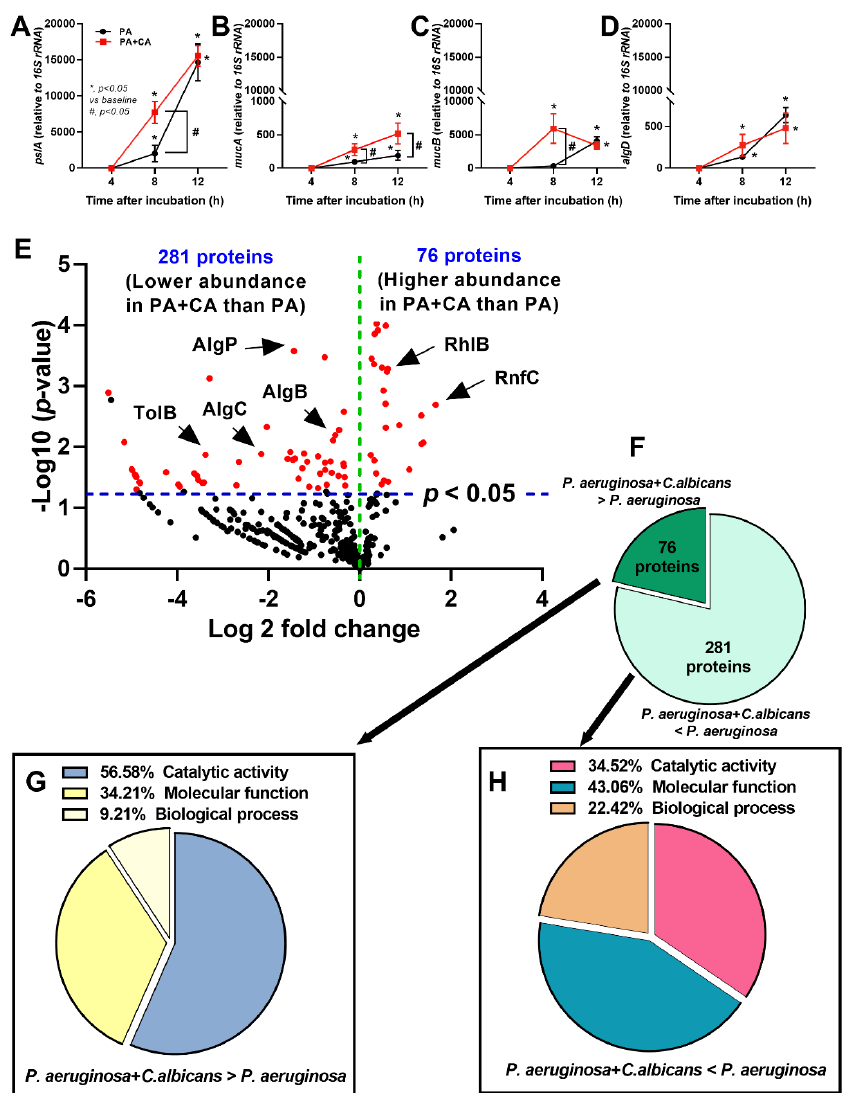
Figure 2. The characteristics of gene-associated biofilms using polymerase chain reaction (PCR) on pulmonary epithelial cells (NCI-H292) from Pseudomonas alone (PA) and Pseudomonas with Candida (PA+CA) are demonstrated ( A – D ) (independent experiments were performed in triplicate). A proteomic analysis of protein from PA+CA in relative to the protein from PA group is indicated by a volcano plot ( E ), and proteins with a higher abundance in PA+CA ( P. aeruginosa + C. albicans > P. aeruginosa ) or a lower abundance ( P. aeruginosa + C. albicans < P. aeruginosa ) with the functional characteristics of proteins from each group ( F – H ) are demonstrated (five samples per group for the proteomic analysis). AlgB, AlgC, and AlgP, proteins used for alginate-based biofilms; TolB, a part of the Tol–Pal system protein on bacterial cell membrane; rhamnosyltransferase RhlB, Psl-associated quorum-sensing protein); and RnfC, iron-translocating oxidoreductase complex subunit